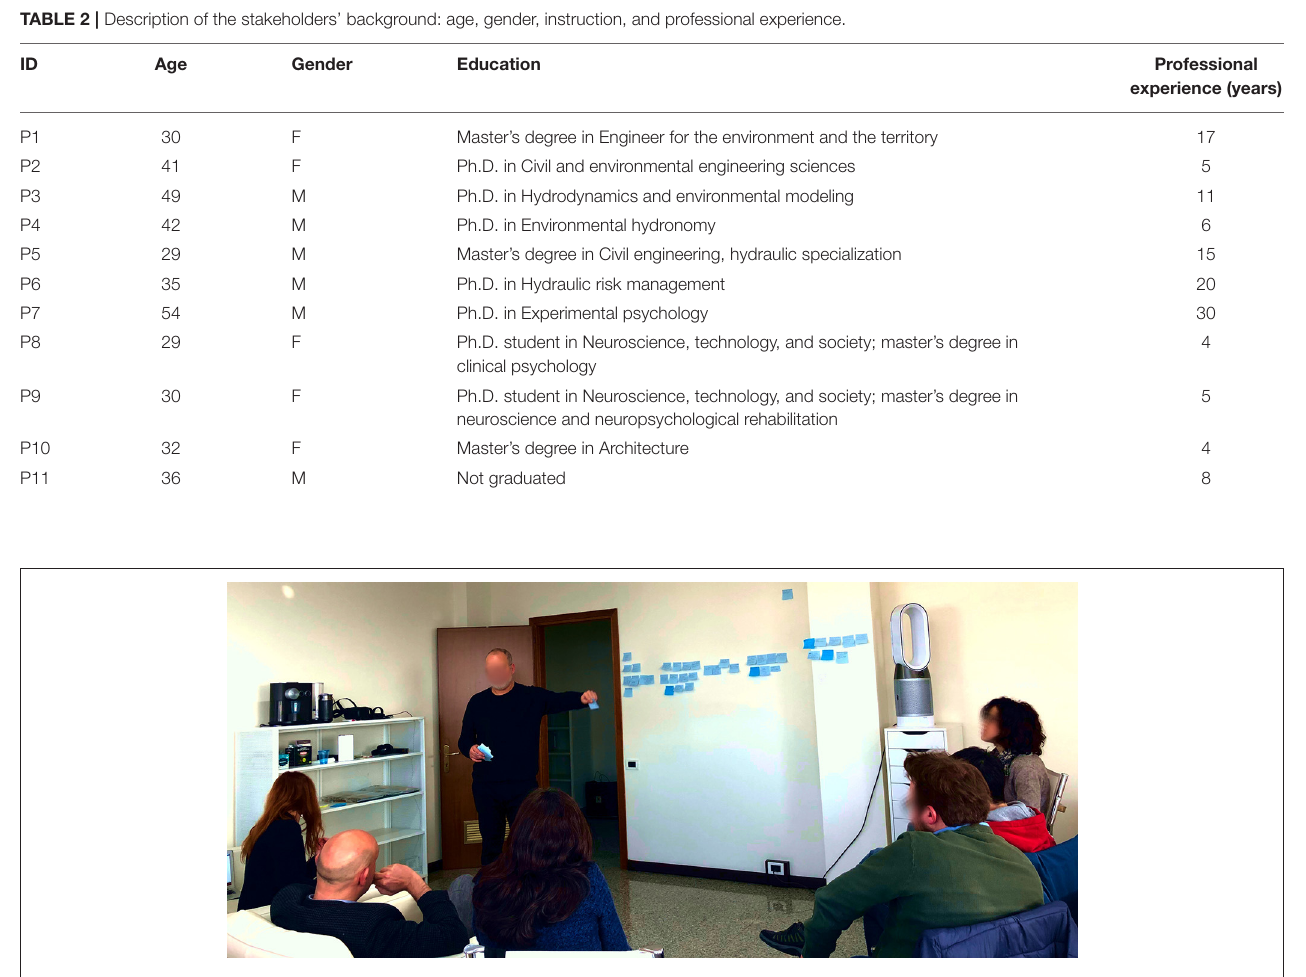
FIGURE 1 | The first affinity diagram